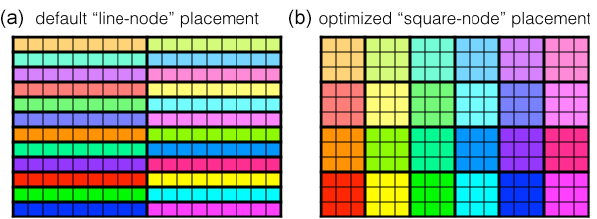
Figure 11. NEMO domain decomposition with the dispatch of the MPI processes among the different nodes. In this schematic repre- sentation, each square represents one MPI process of NEMO. We consider that NEMO is distributed over 216 MPI processes and that each node has 9 cores. The distribution of the MPI processes on the cores is represented by their color: processes on the same node have the same color. (a) Default dispatch of the MPI processes in lines; (b) optimized dispatch of the MPI processes in